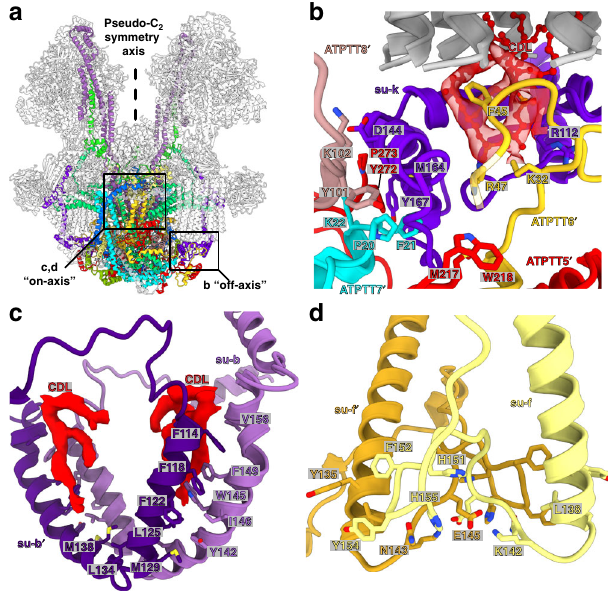
Fig. 5 Dimer interfaces are scattered throughout the F o -subcomplex. a Overview of ATP synthase dimer structure with F o subunits participating in dimer interfaces shown with their respective colors. Windows indicate regions shown in panels b-d close-up views. b The extended C-terminal domain of subunit- k engages in several dimer interface interactions below the c-ring with F o subunits ATPTT5-8 ′ . A bound cardiolipin (CDL, red) mediates interactions between subunit- k and ATPTT6 ′ . c Subunits b and b ′ form a hydrophobic dimer interface with cardiolipins (CDL, red). Cardiolipin density is carved 2.6 Å around atoms in F o -dimer local-resolution fi ltered map. d Subunits f and f ′ form a dimer interface through electrostatic, polar and hydrophobic